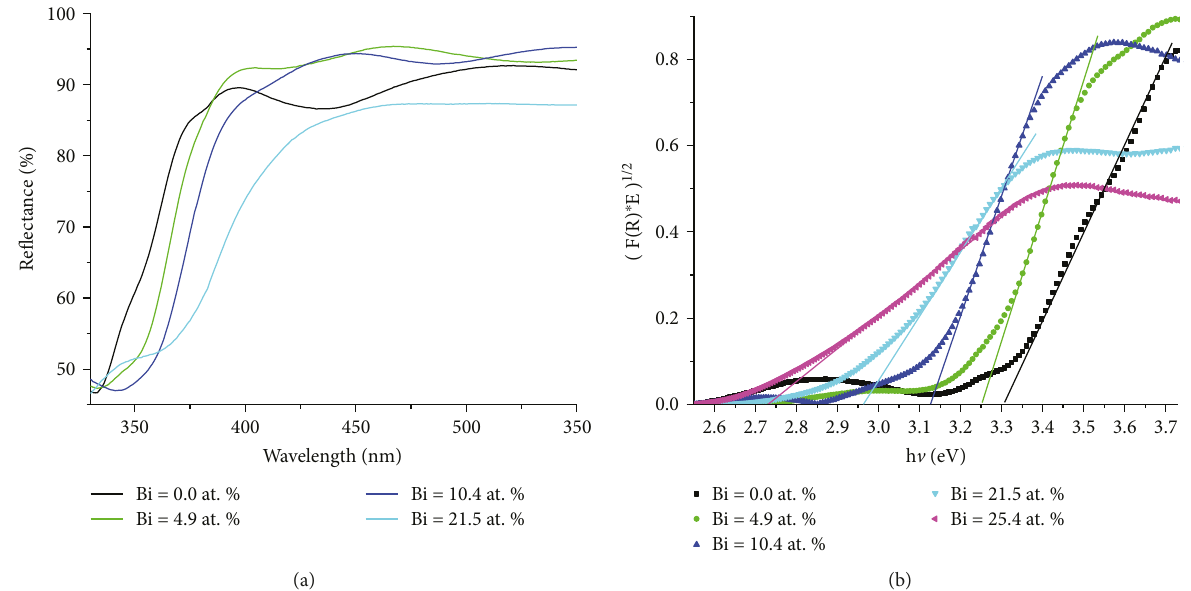
Figure 9: (a) Re fl ectance spectra and (b) (F(R) E) 1/2 versus E graphs of the prepared fi lms.